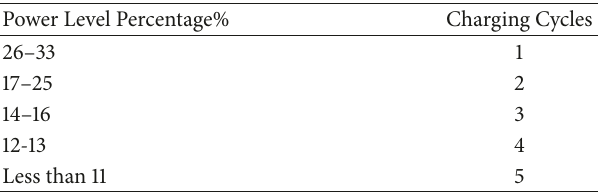
Figure 4: Voltage and current of microinverter at different RLC- load power levels (1, 10, and 100 times rated power). Table 2: Charging cycles by power